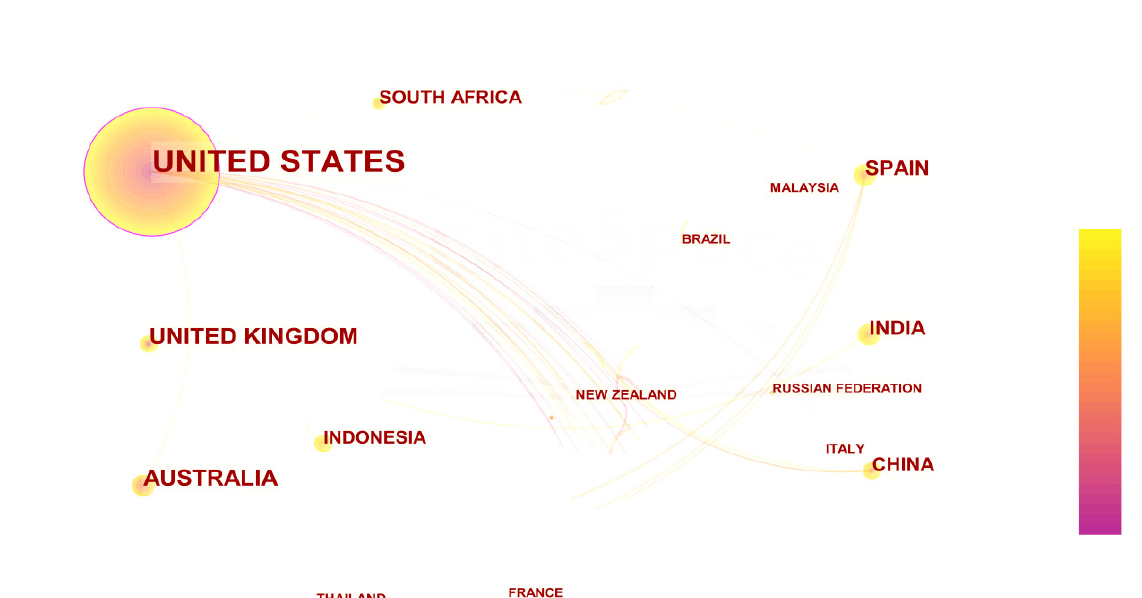
Figure 3. Country co-occurrence map of IMC research (Scopus